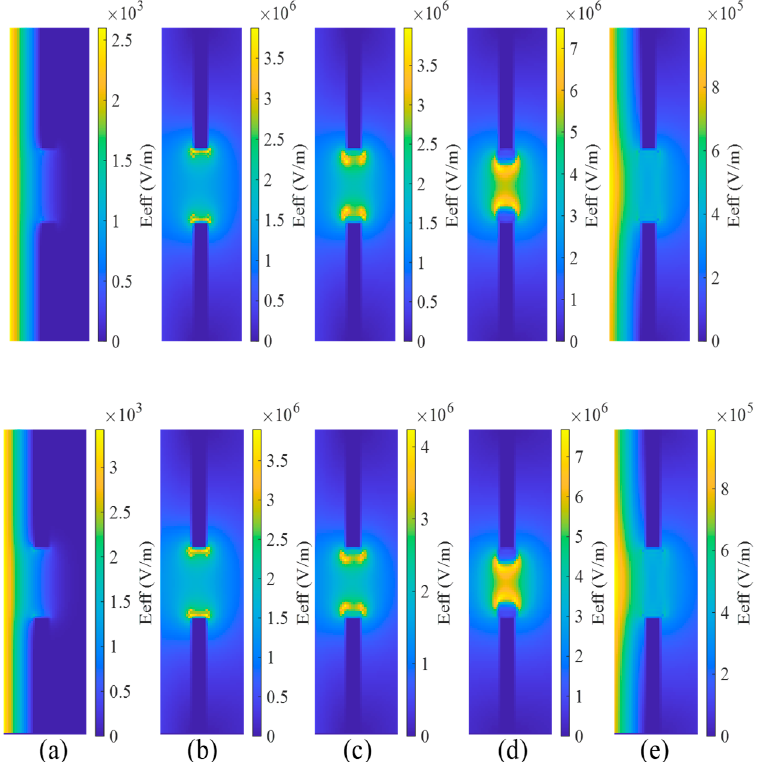
Figure8. Thetimeevolution oftheeffectiveelectricfield E ef f inthey–z planeinthe densegrid (upper panel) and subgrid (lower panel) at ( a ) 0.01 ns, ( b ) 0.36 ns, ( c ) 0.42 ns, ( d ) 0.45 ns, and ( e ) 0.1 ns.